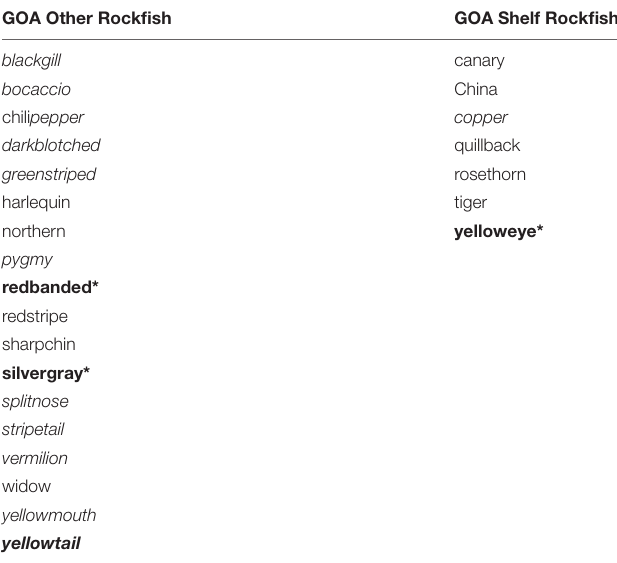
TABLE 2 | Suggested assemblages for species complexes based on the analysis of all available data and clustering